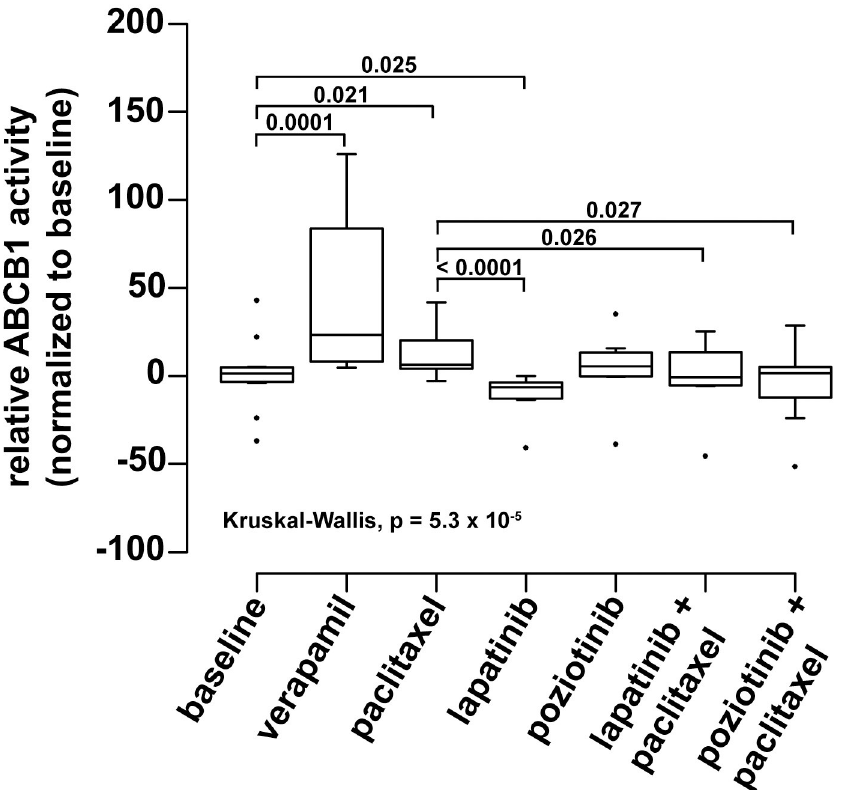
Fig 6. Lapatinib and poziotinib directly inhibit ABCB1-mediated paclitaxel transport. ABCB1 ATPase activity was measured in untreated (baseline) and drug-treated recombinant human ABCB1 membranes and normalized to baseline activity. Verapamil served as positive control. Box and whisker plots depict the median activity, interquartile range (boxes) with whiskers extending to data points up to 1.5x the interquartile range (IQR). Outlier values greater than 1.5x IQR are shown as closed circles. Statistical significance was determined using Kruskal-Wallis test followed by Conover-Iman tests for pair-wise comparisons.